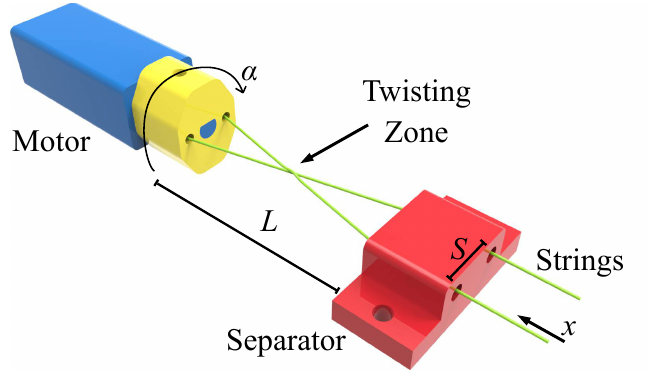
Figure 7. Twisted string system. With an electric motor (blue), strings (green), connection between motor shaft and strings (yellow) and separator (red). Where L is twisting zone length, α is the rotational angle of the motor shaft, x is the linear displacement of the strings and S is the distance between the holes of the